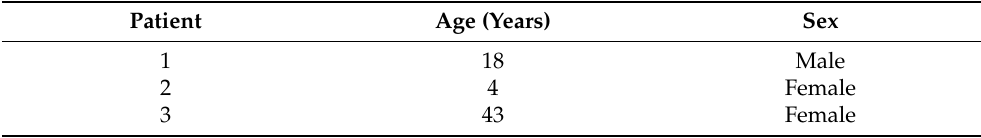
Table 3. Patient information